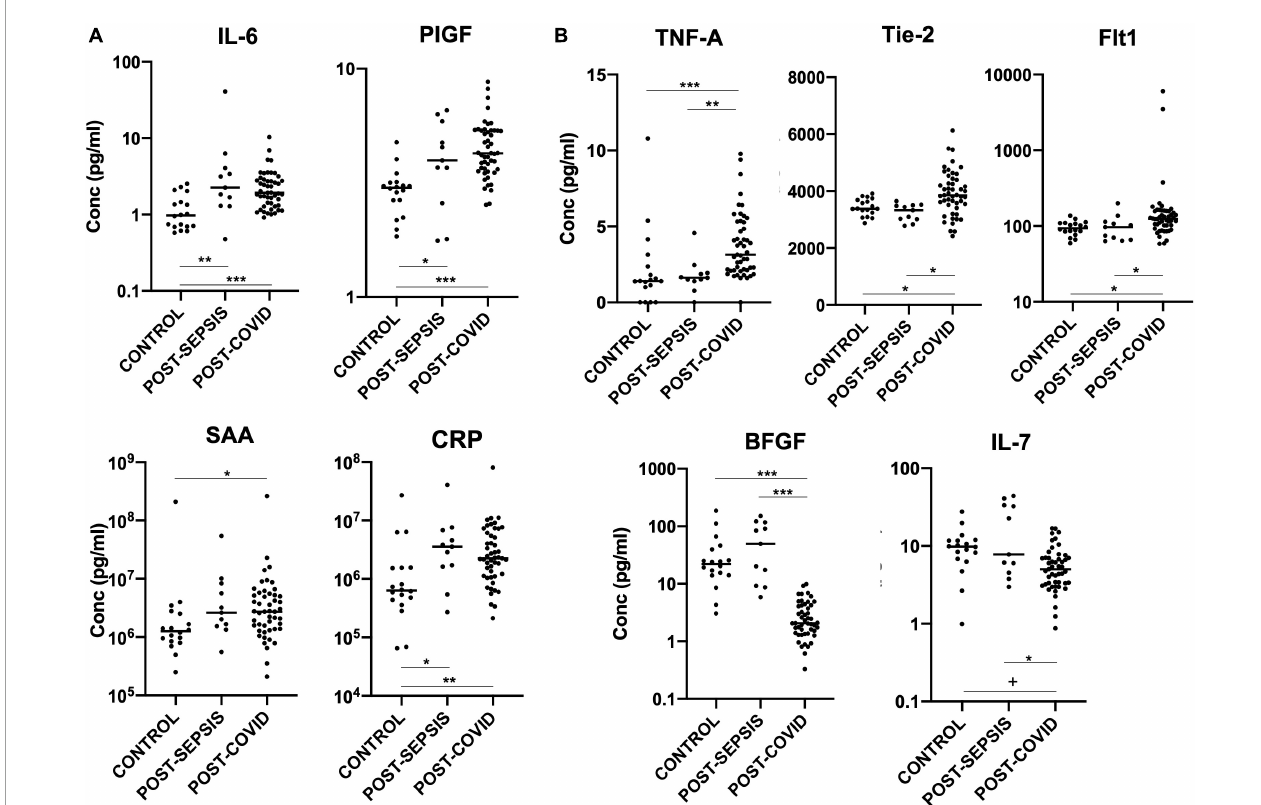
FIGURE1 (A) Plasma markers elevated in both post-COVID and post-Sepsis groups, compared to healthy controls: IL-6, PIGF, SAA, and CRP. (B) Plasma markers uniquely different in post-COVID patients but not in post-Sepsis patients compared with healthy controls: TNF α , Tie-2, and Flt-1 are elevated while bFGF and IL-7 are depressed in post-COVID patients compared to healthy controls and compared to post-Sepsis patients. Horizontal bars indicate medians. + p < 0.01, * p < 0.05, ** p < 0.005, *** p <